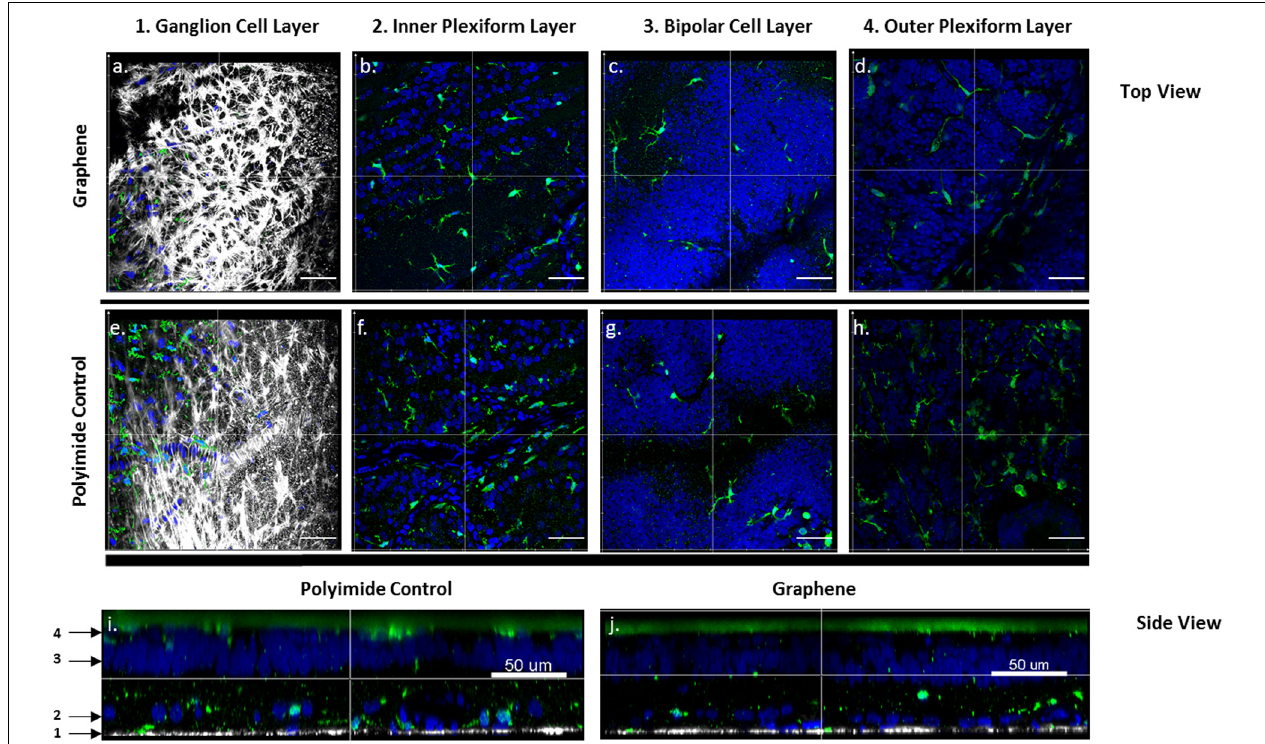
FIGURE 5 | Microglial distributions within the retinal tissues at the graphene (a–d,j) and control polymer interface (e–i) . Confocal images of the retinal tissues showing Iba1-positive microglia cells (green) at different depths. (a,e) Optic fiber layer showing GFAP-positive Müller and astrocyte cells (white) and no microglial cells. Iba1-positive microglial cells with DAPI-stained nuclei (blue) at the junction between the inner plexiform layers (IPL) and the ganglion cell layer (GCL) (b,f) , in the inner nuclear layer (INL) (c,g) in the outer plexiform layer (OPL) (d,h). Confocal reconstruction of vertical sections for the retina above the control polymer implant (i) and the graphene implant (j) showing the different depths (1–4) for all above horizontal sections (a–h) . Scale bars represent 100 µ m in (a–h) and 50 µ m in (i,j) .